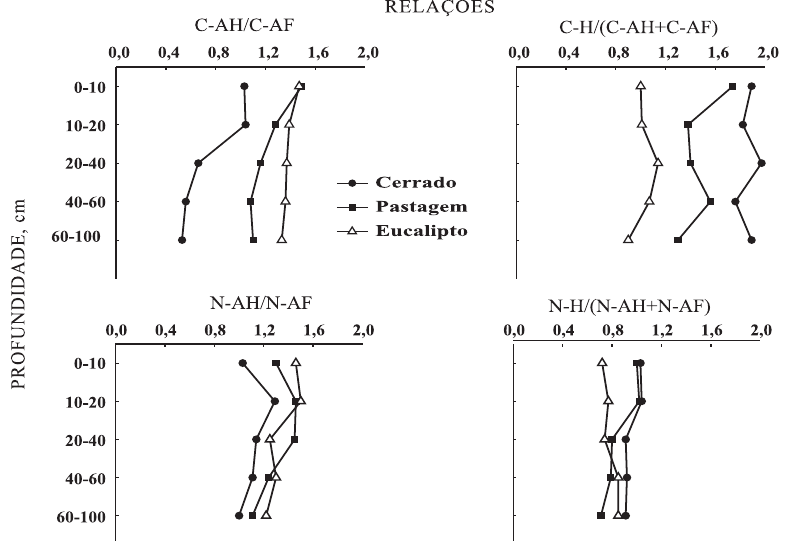
Figura 3. Relações de carbono orgânico total (COT) e nitrogênio total (NT) das frações humina, ácidos húmicos (AH) e ácidos fúlvicos (AF) nos solos sob diferentes coberturas vegetais (Cerrado, pastagem e